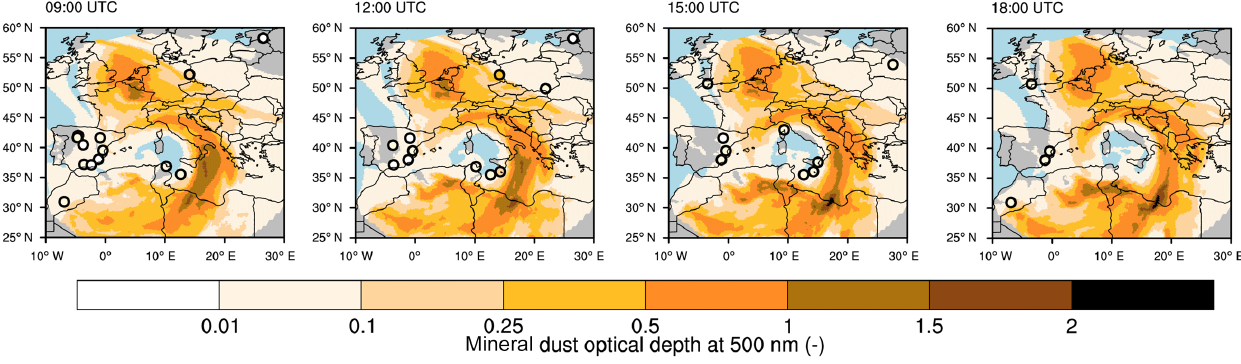
Figure 7. Mineral dust optical depth at 500nm over Europe on 4 April 2014 at 09:00UTC, 12:00UTC, 15:00UTC and 18:00UTC (TT case) at 20km grid spacing. The filled circles represent observations from AERONET stations. Note the saw-tooth shape next to the borders which marks the margin of nest R2B07 and must not be confused with mineral dust-free